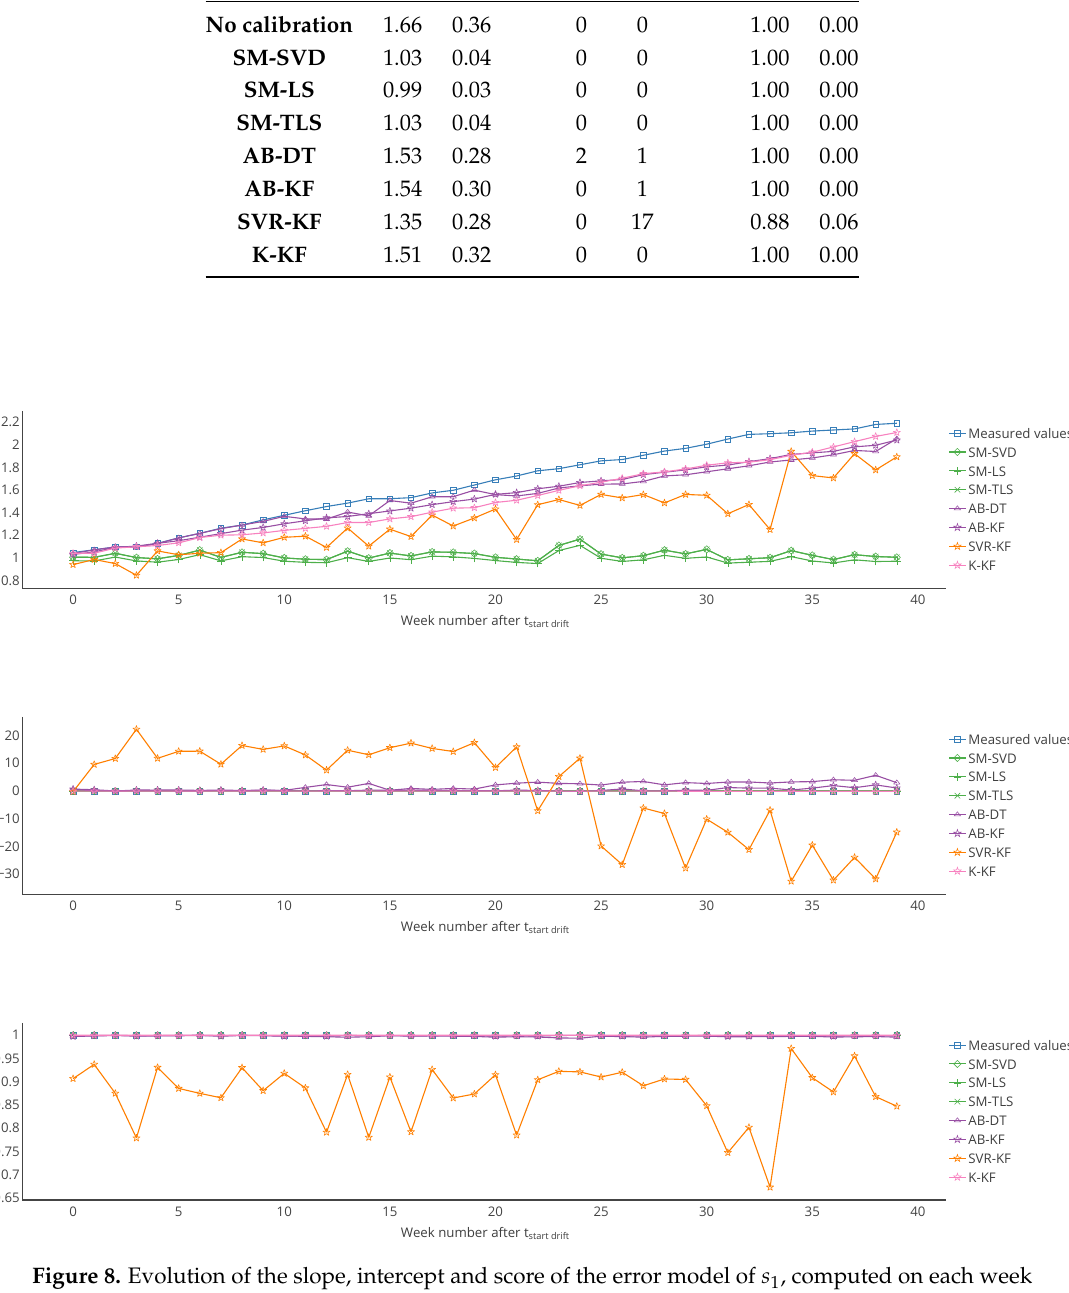
Figure 8. Evolution of the slope, intercept and score of the error model of s 1 , computed on each week of the drift period. From these figures we observe that both the slope and intercept are locally poor for SVR-KF, although this is not visible when computing the error model on the entire time interval of study. This explains the poor values of the score for this algorithm. Regarding the other strategies, the intercept and score are quite constant. The slope is also quite constant for SM-(SVD, LS, TLS) but it mainly follows the evolution the slope of the measured valued for AB-(DT, KF) and